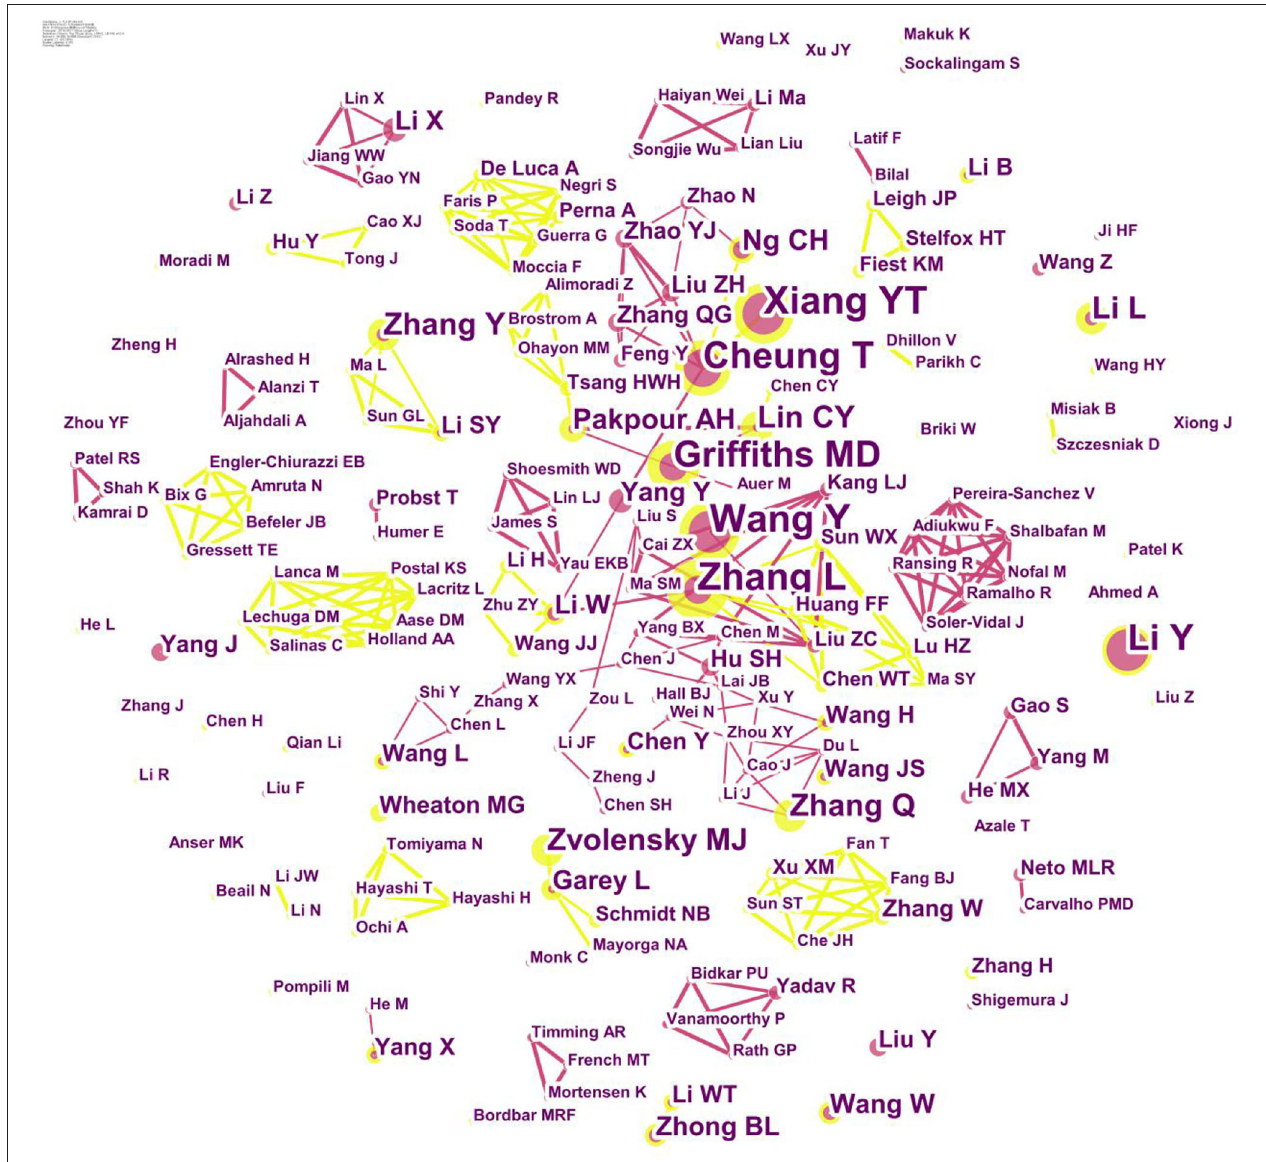
FIGURE 3 | Author